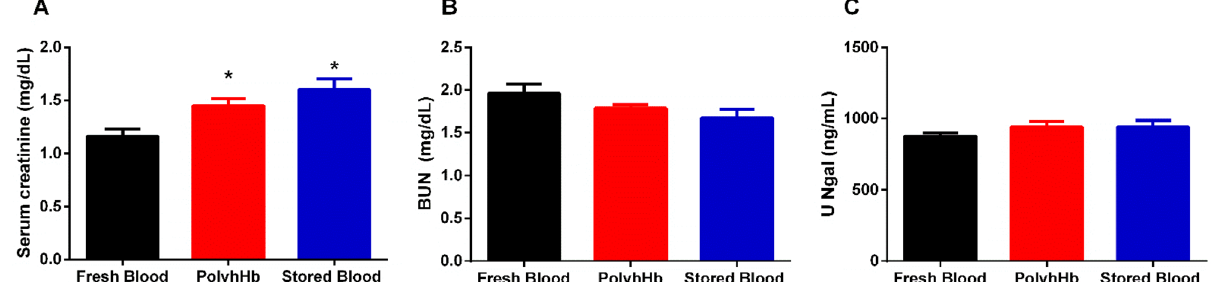
Figure 3. Markers of kidney function after resuscitation. Stored blood and PolyhHb groups indicate changes in kidney function compared to the fresh blood group, as observed by increased serum creatinine. However, the level of dysfunction could be transient since BUN and U Ngal, both kidney damage markers, did not change when compared to the fresh blood group. ( A ) Serum creatinine; ( B ) Blood urea nitrogen (BUN); ( C ) Urinary neutrophil gelatinase-associated lipocalin (U Ngal). Measurements were taken 24 h after resuscitation. *, p < 0.05 versus Fresh Blood. Statistical comparisons were completed using a one way—ANOVA; Tukey’s multiple comparison